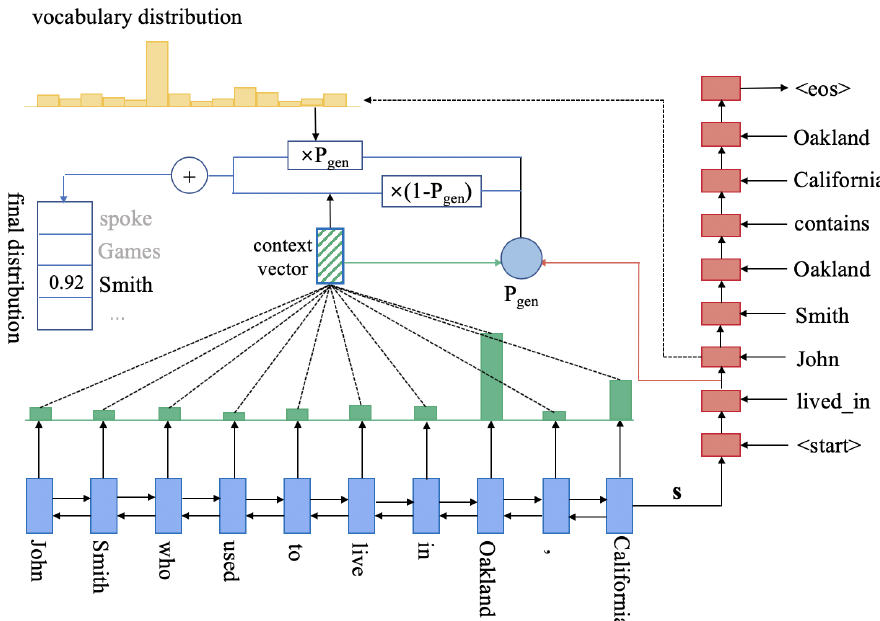
Figure 1. The overall structure of our model. The blue block represents the bidirectional LSTMs in the encoder, the red block represents the unidirectional LSTM in the decoder, the green block represents the attention weight distribution, and the yellow block represents the final generation probability distribution. All these above descriptions will be introduced in Section